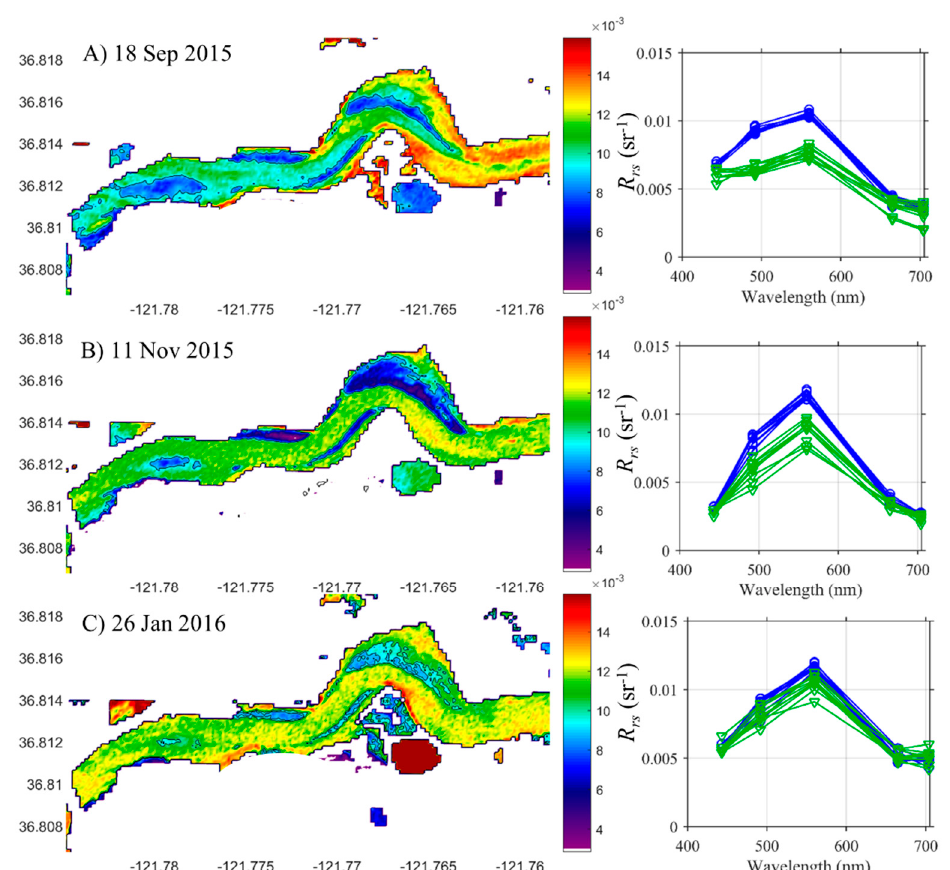
Figure 8. Sentinel-2 images obtained in 2015 and 2016 over Elkhorn Slough reveal darker patches related to the five eelgrass beds. Retrieved remote sensing reflectance at 560 nm can be used to quantify the extent of eelgrass beds based on low reflectance ( < 0.009) with black contour line provided. For panel C, an additional contour line at 0.01 was added. The right panels show the remote sensing reflectance from over the Vierra seagrass bed (green) compared to sediment seafloor near the W. Lobo buoy (blue) for each image.